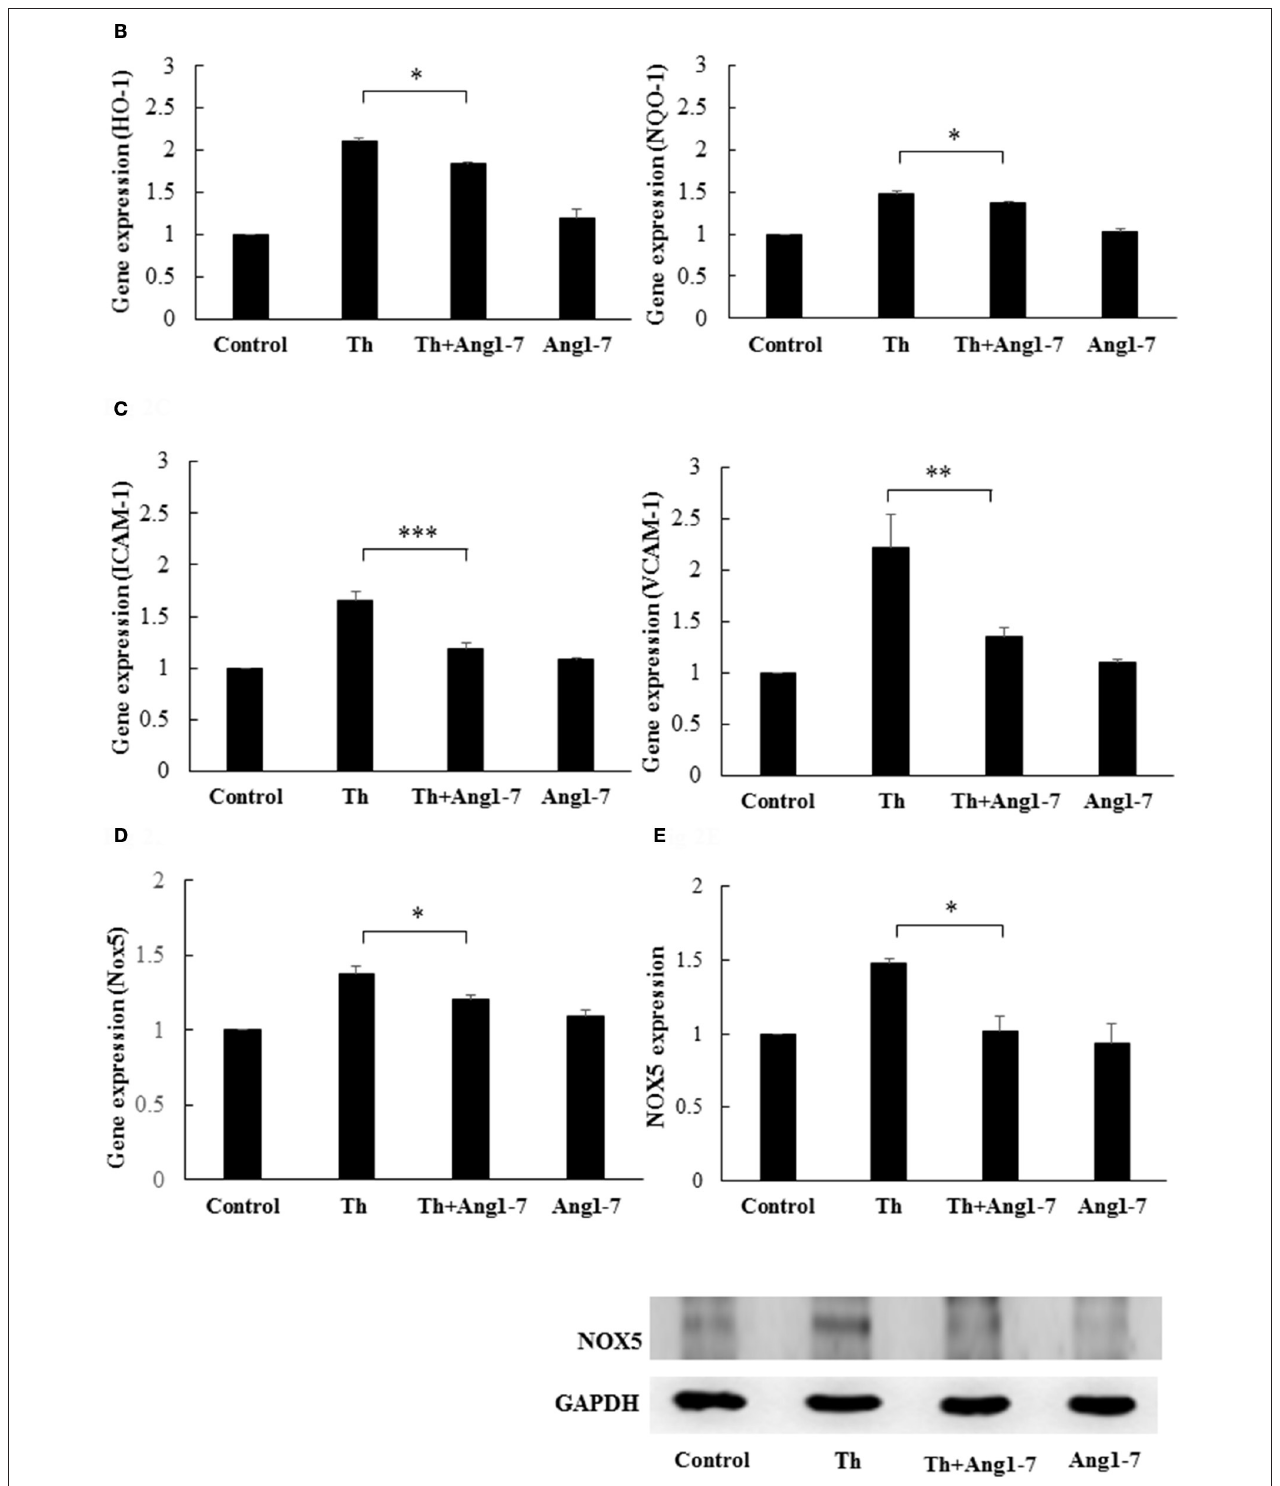
FIGURE 2 | (D) Thrombin caused a significant increase in the Nox5 mRNA level, while angiotensin-(1-7) pretreatment decreased Nox5 mRNA expression. n = 4, p < 0.05 for thrombin compared with thrombin + angiotensin-(1-7). GAPDH was used as the internal control for data normalization in all real-time PCR analyses. (E) Thrombin induced significant Nox5 protein expression, while angiotensin-(1-7) decreased the thrombin-induced Nox5 protein expression level. The blot represents results from three independent experiments. * p < 0.05 for thrombin compared with thrombin + angiotensin-(1-7).